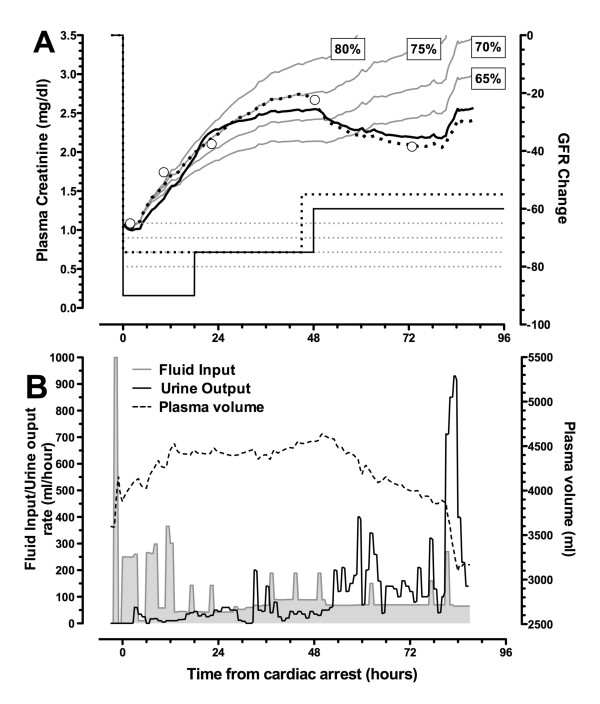
Case A: Crincrease. Effect of changing glomerular filtration rate (GFR) on calculated plasma creatinine is shown. (a) Plasma creatinine. Open circles represent measured plasma creatinine concentrations, and solid grey lines represent modeled plasma creatinine concentrations according to respective GFR decreases of 65%, 70%, 75%, and 85%. The dotted black line represents the best-fit modeled plasma creatinine that results from step changes in GFR shown at the bottom of panel (a) (right axis). The solid black line represents the best fit taking into account a loss of creatinine production, assumed to be the same as the median loss modeled for the Crdecrease group (Figure 4b), in addition to changes in GFR. This suggests that the measured creatinine values can be explained by an immediate 90% decrease in GFR followed by two step increases of approximately 15% in GFR with an initial decrease in creatinine production of 25%. (b) Measured fluid input (shaded area), measured urine output (solid line), and calculated plasma volume (dashed line). The rate of fluid input initially exceeded urine output, resulting in increases in total body water and in plasma volume. Plasma volume returned to normal toward the end of this period. Crincrease, group of patients with a plasma creatinine increase of more than 20% at 24 hours after cardiac arrest.